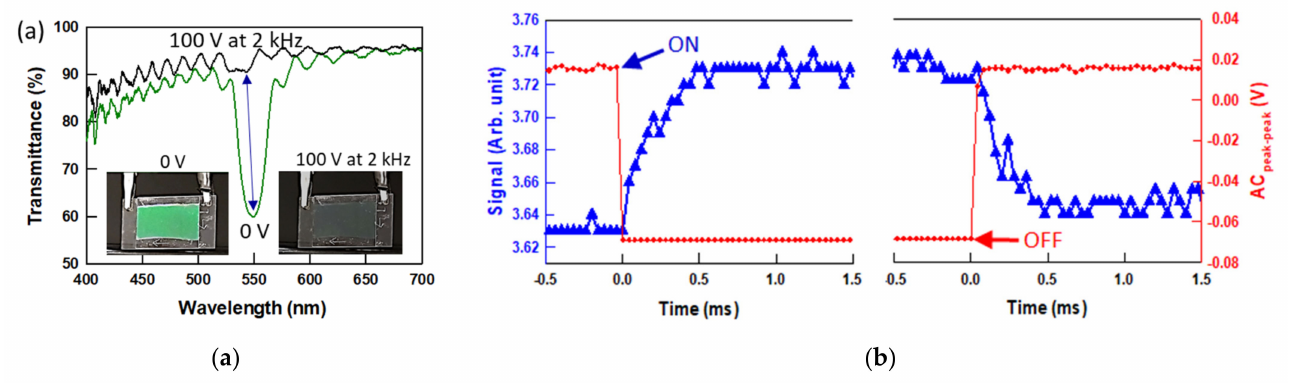
Figure 6. ( a ) Transmission spectra of the reflective to transparent switching response and green to transparent reflection color change (inset image) and ( b ) optical signal of 4.7 µ m thick PSBPLC-3 when an AC voltage of 100 V at 2 kHz is turned on and